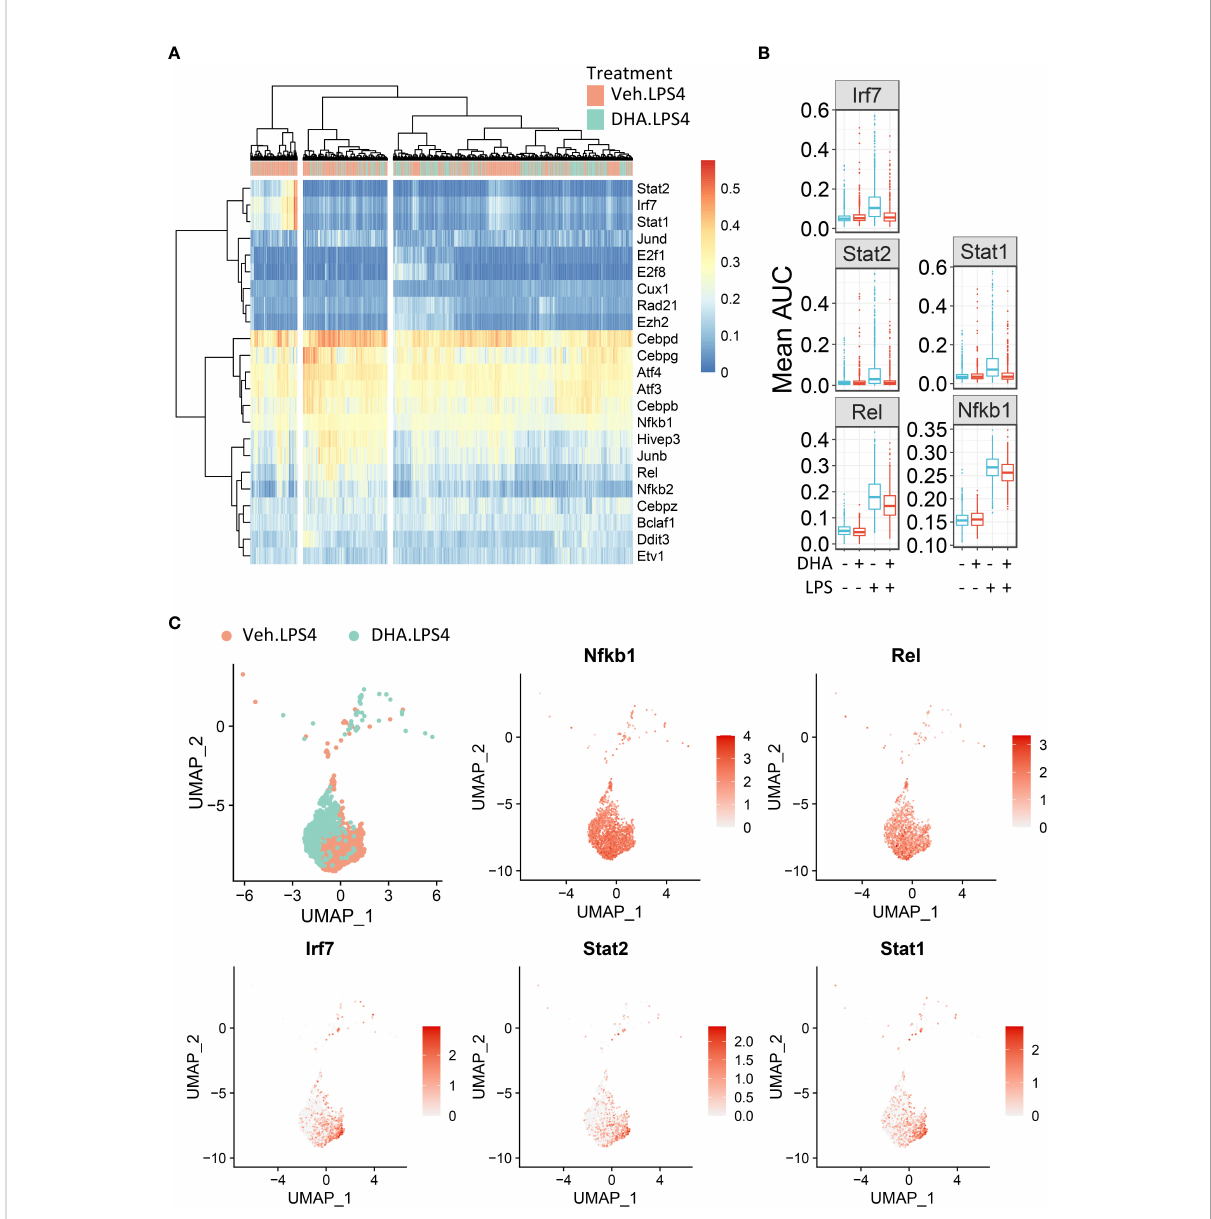
FIGURE 10 FLMs with high IFN1-regulated gene expression cluster together. (A) Regulon scores for cells in each group were generated using the SCENIC work fl ow. Regulons were selected that were signi fi cantly different between Veh.LPS.4 and DHA.LPS.4. Cells in the Veh.LPS.4 and DHA.LPS.4 treatment groups (as indicated by the horizontal bar above the heatmap) were analyzed for selected regulons. Clustering was performed using Ward ’ s method in the pheatmap tool in R Studio. The regulon AUC values were directly plotted without scaling the heatmap. (B) Boxplots for regulon scores were generated to identify differences between treatment groups. Irf7, Stat1, Stat2, NF- k B, and Rel regulons were increased by LPS at 4 hr. DHA reduced the regulon scores for NF- k B and Rel regulons and completely suppressed scores for Irf7, Stat1, and Stat2 regulons scores. (C) The Seurat FeaturePlot function was used to color cells from Veh.LPS.4 and DHA.LPS.4 treatment groups according to Irf7, Stat1, Stat2, Rel, and NF- k B1 regulon